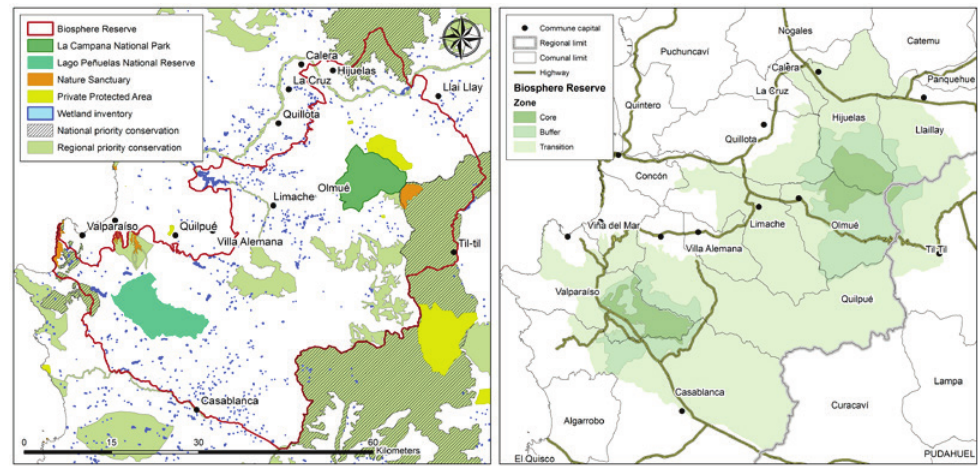
Figure 2. Conservation and administrative units within Biosphere Reserve